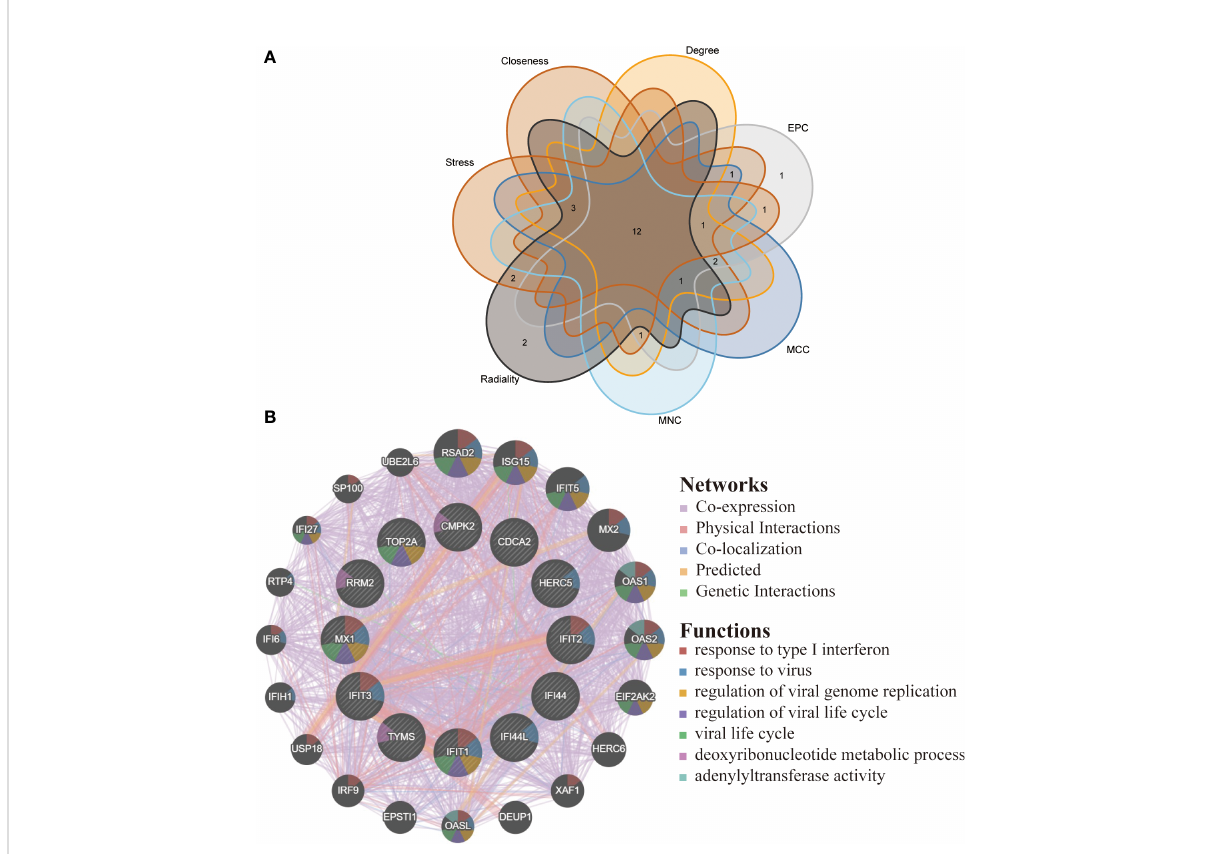
FIGURE 6 Venn diagram and co-expression network of hub genes. (A) The Venn diagram showed 12 overlapping hub genes screened by 7 algorithms. (B) Hub genes and their co-expression genes were analyzed via GeneMANIA.